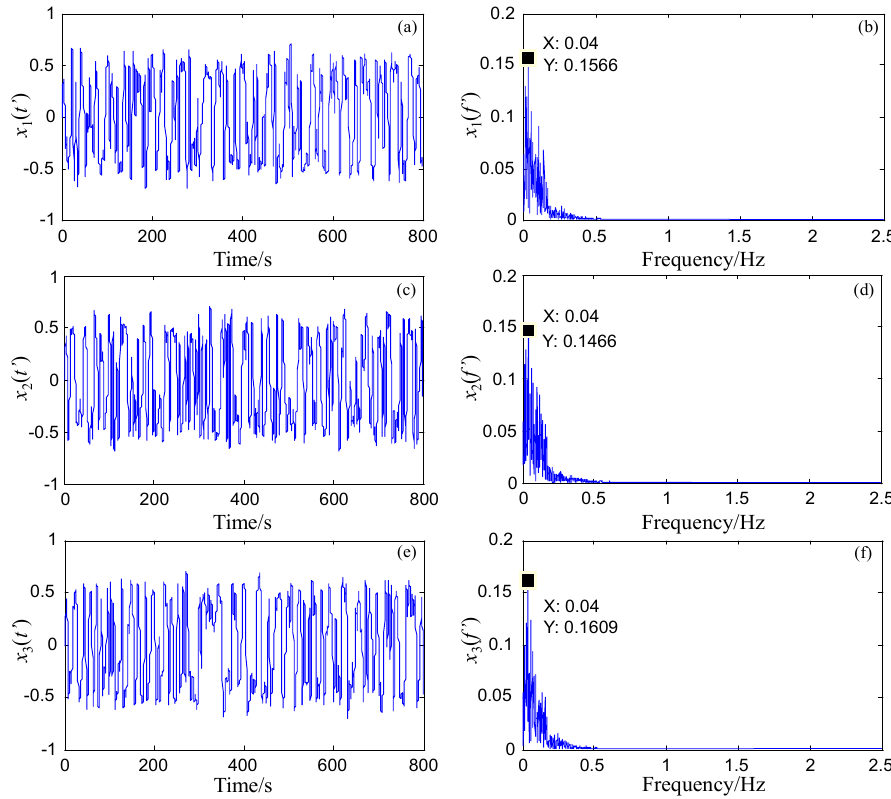
Figure 6. The detection of multi-frequency non-harmonic signal based on FERSR. ( a , c , e ) are the time-domain waveforms of the response of the FERSR system to the target signals with 42 Hz, 95 Hz, and 243 Hz respectively; ( b , d , f ) are the corresponding frequency spectra of the response of the FERSR system to the target signals.